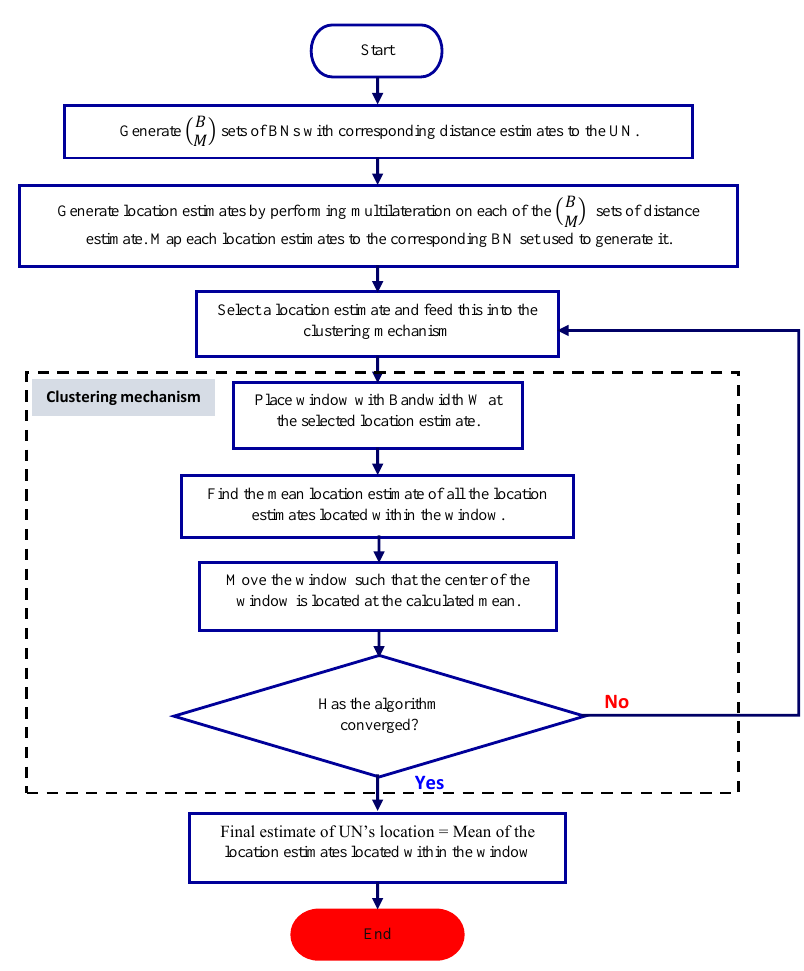
Figure 12. OD_MSC Outlier detection localization scheme